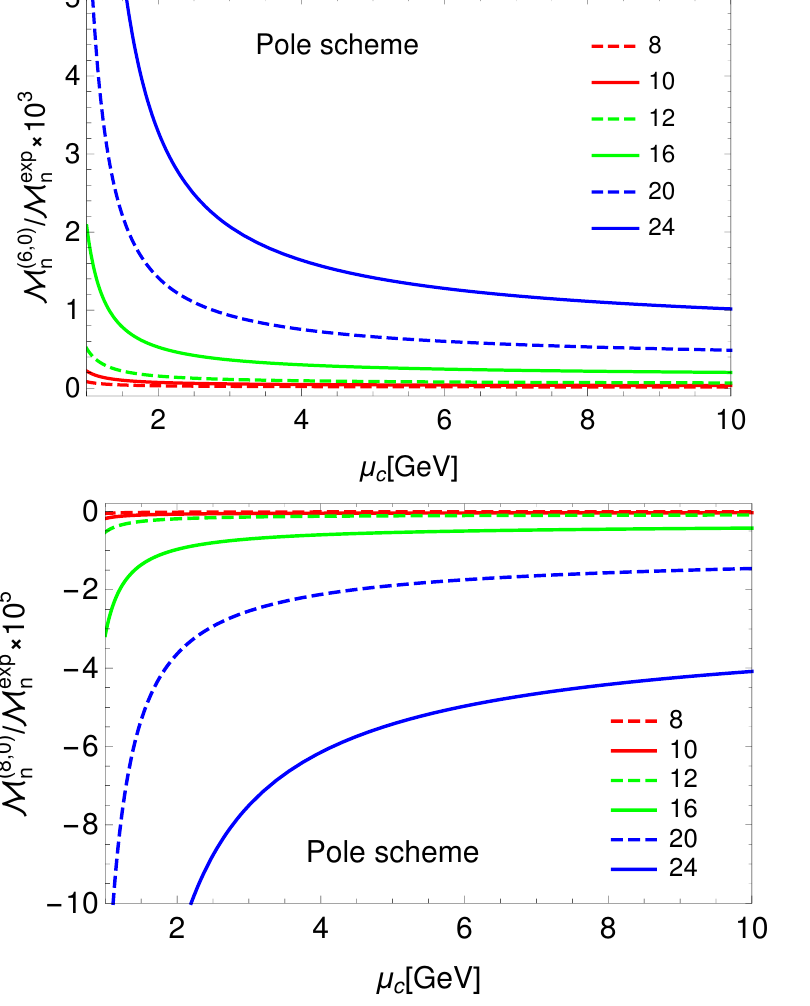
Figure 9 . Relative corrections to the non-relativistic moments from the condensate contributions of dimension six (upper panel) and eight (lower panel). The relative corrections have been rescaled by factors of 10 3 and 10 5 ,